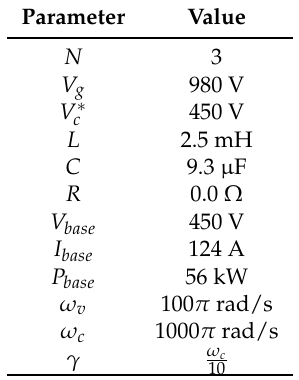
Table 1. Parameters used in PSCAD/EMTDC